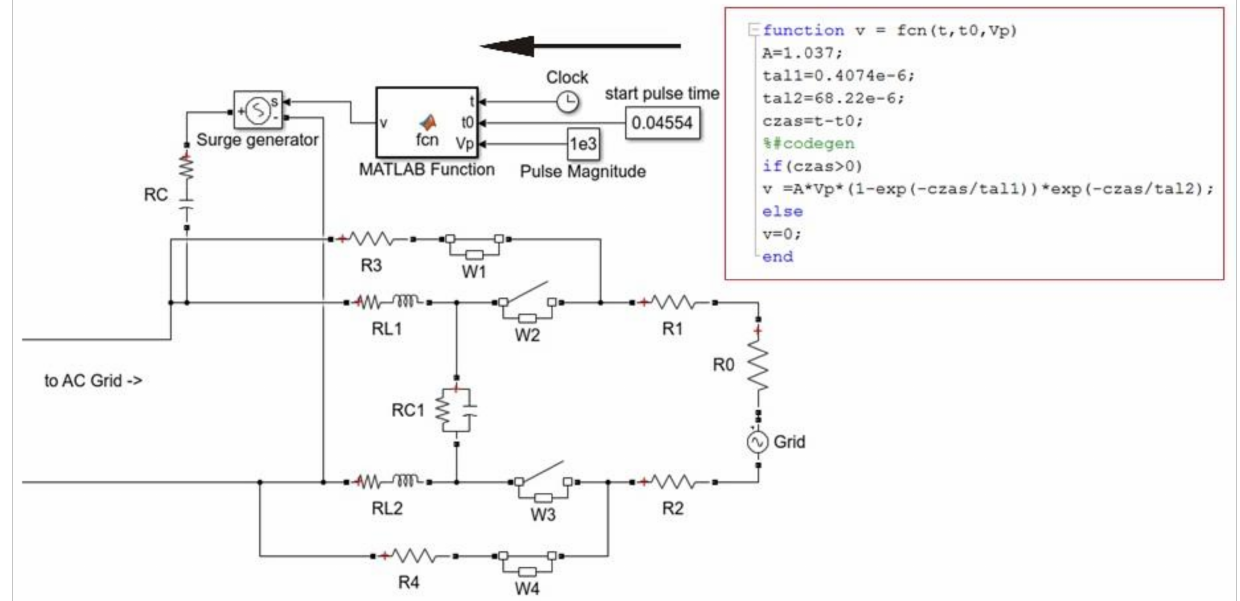
Figure 5. CDN model and surge generator implementation for the immunity test. W1, W2, W3, and W4 circuit breakers in the system were used to switch on and off the coupling and decoupling system at the time of voltage surge. This eliminated the influence a surge occurred. The values of resistance (R1–R4), resistance-inductive (RL1 and RL2),